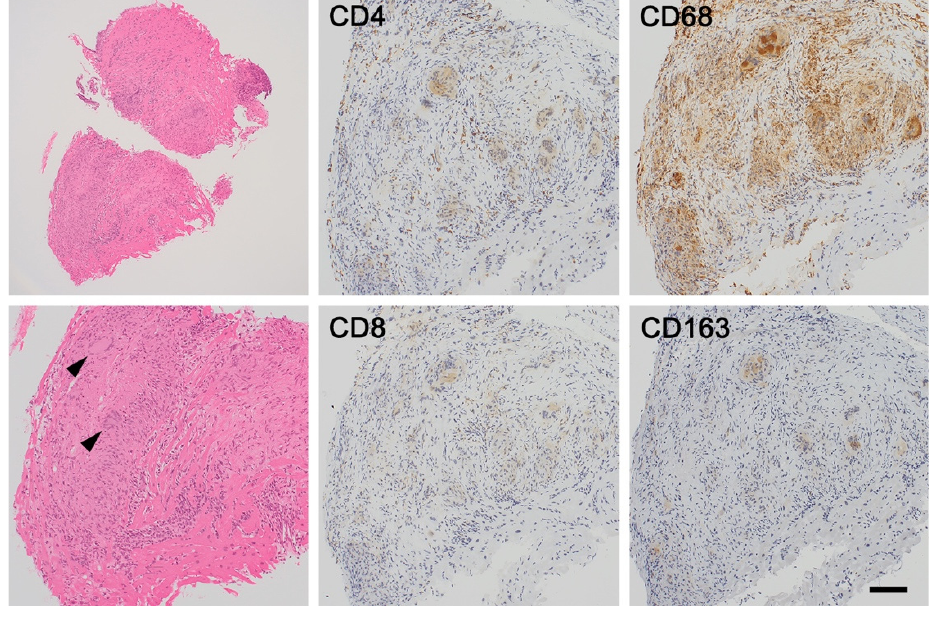
Figure 3. Granulomatous phase of cardiac sarcoidosis. Well-formed noncaseating granulomas (arrowhead) are composed of aggregates of tightly clustered epithelioid macrophages, often with multinucleated giant cells of Langhans and foreign-body types. Few CD4 + helper T cells are surrounded by granulomas, and they are often described as “naked granulomas”. Most of macrophages and giant cells accumulated express CD68 + CD163 − M1 phenotype. Bar = 250 μ m for a lower magnification field, 100 μ m for higher magnification fields.